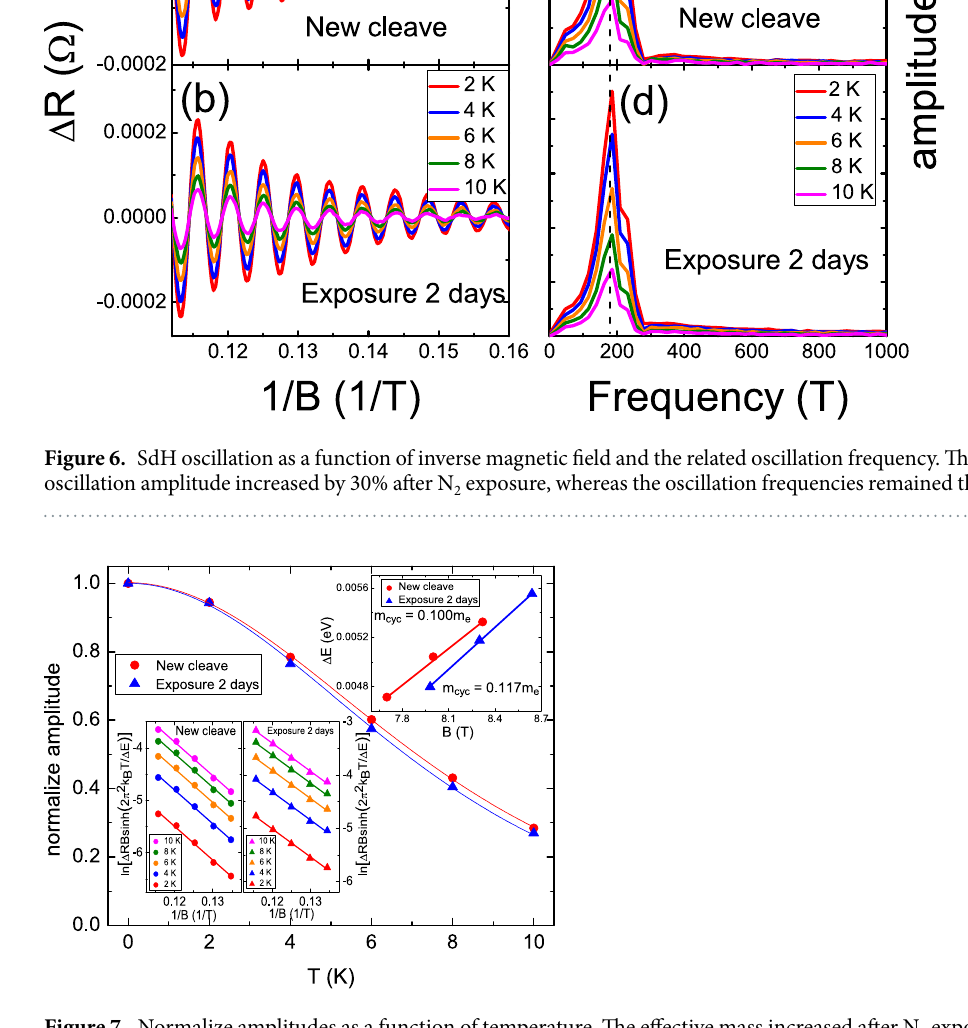
Figure 7. Normalize amplitudes as a function of temperature. The effective mass increased after N 2